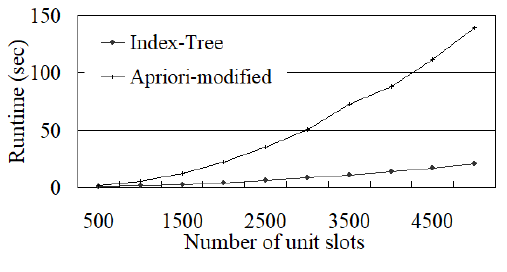
Fig. 15 Runtime vs. number of unit intervals ( d = 10K, m = 5%, s =